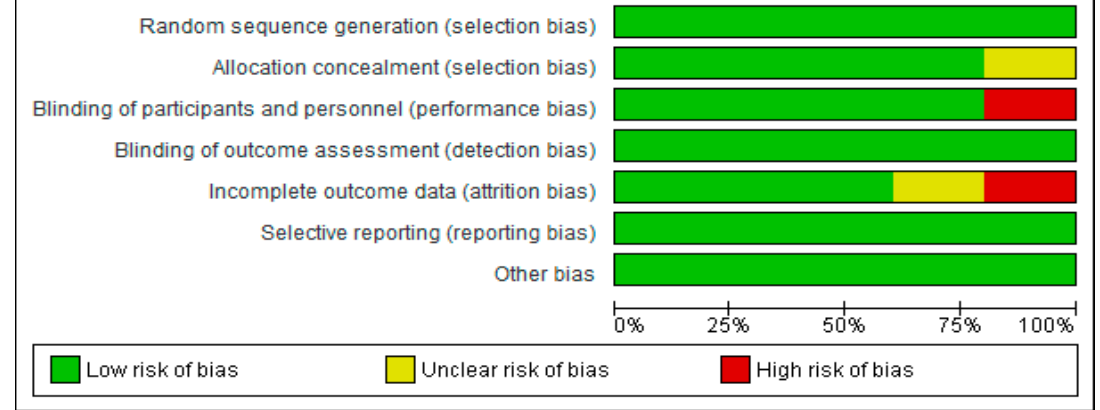
Figure 2. Risk of bias graph per type of bias assessed. Int. J. Environ. Res. Public Health 2019 , 16 , x